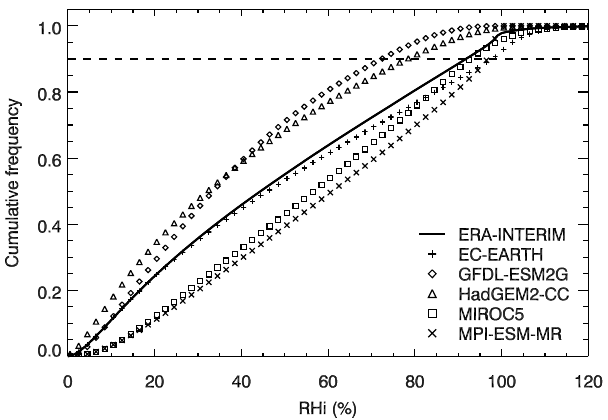
Figure 1. Cumulative frequency distribution of 250hPa relative humidity with respect to ice for ERA-Interim (solid line) and the CMIP5 models (symbols). Global daily data over the period 1979– 2005 are used. The dashed line marks the 90th percentile of the RHi distribution, used to define the model-dependent RHi threshold for ice-supersaturated regions.